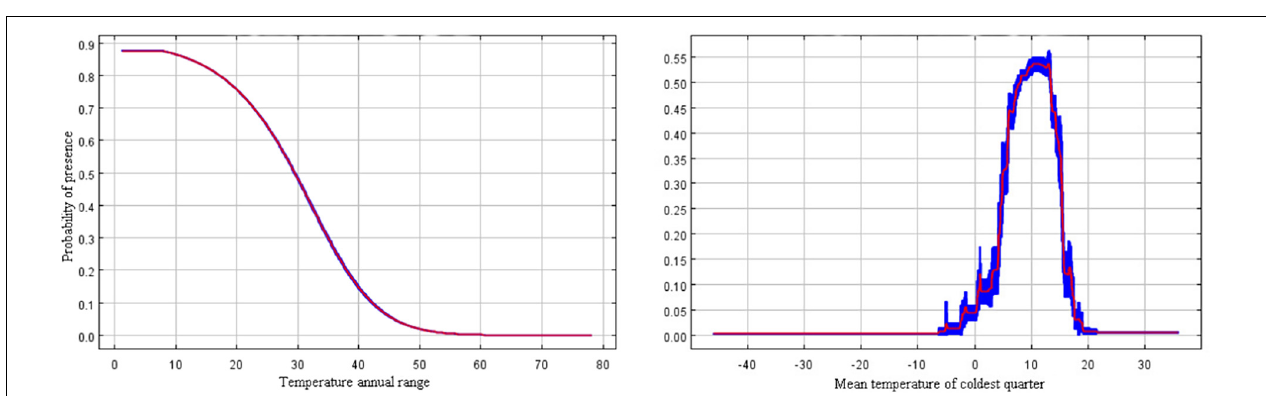
FIGURE 4 | Response curves of the presence probability of Rapistrum rugosum